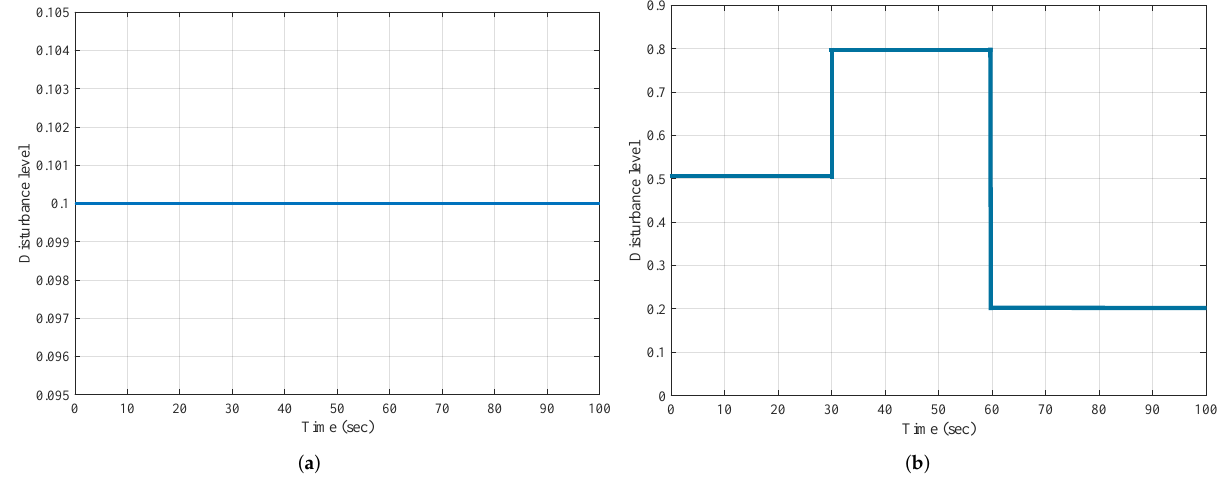
Figure 9. The conducted disturbance on area 2 (PV unit): ( a ) step of 10% and ( b ) variable step